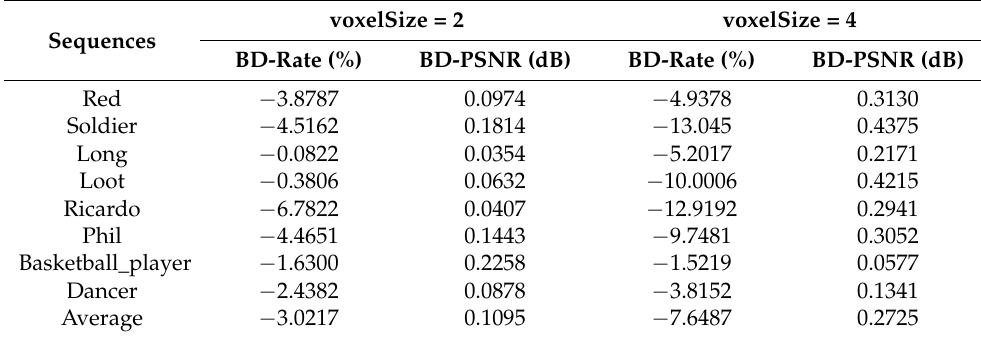
Table 3. The BD-rate and BD-PSNR in Y color component for our method in comparison with